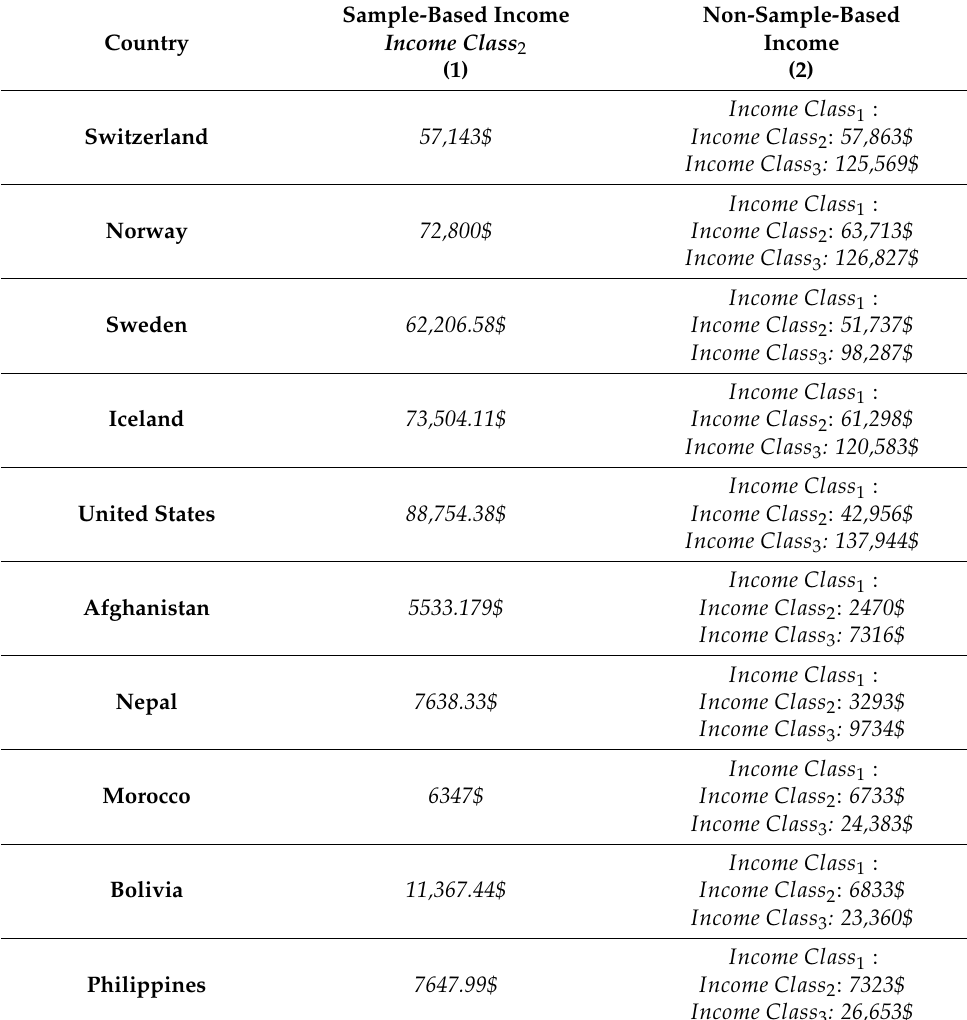
Table A2. Validity of income cut